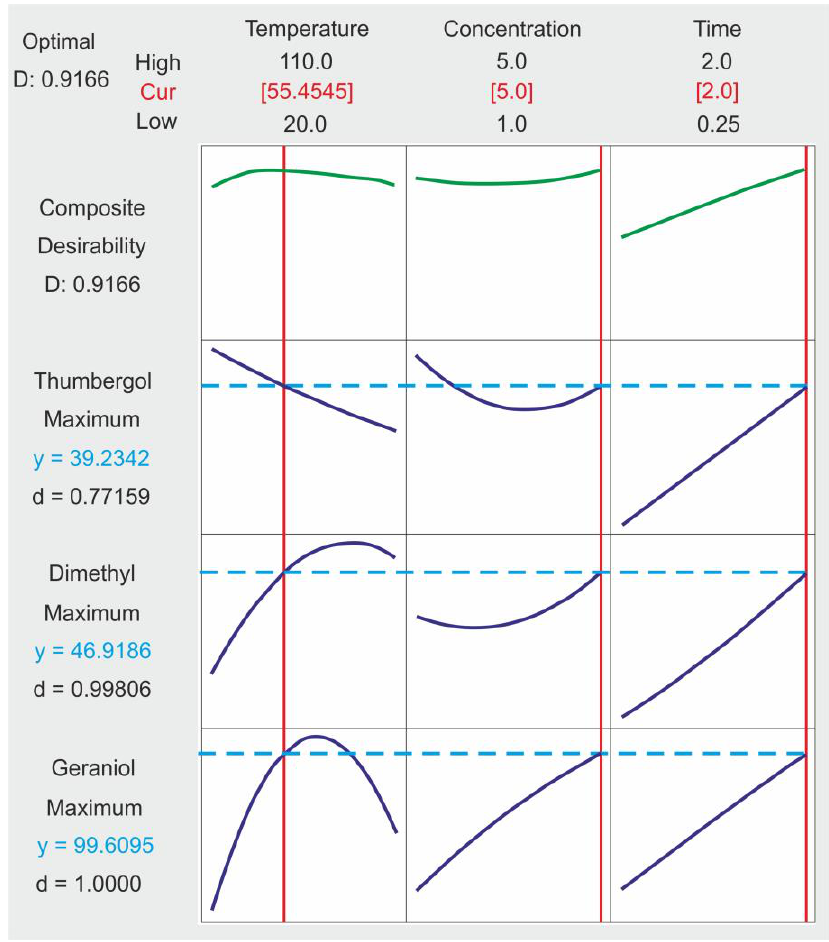
Figure 7. Control factors at optimal levels for each output factor.